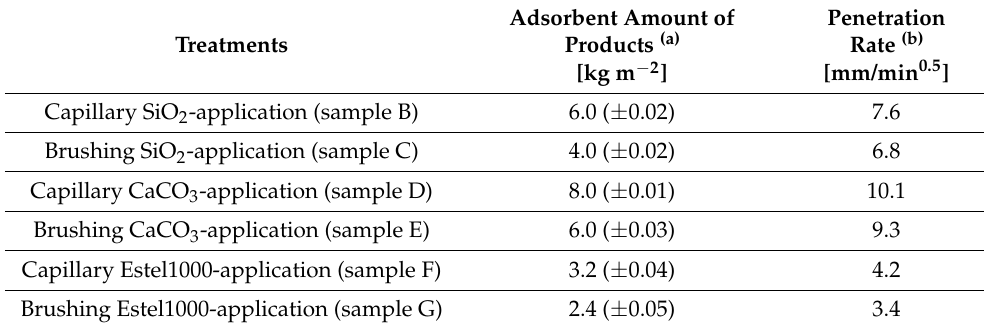
Table 5. The adsorbed amount of SiO 2 nanodispersion and penetration rate on Pietraforte